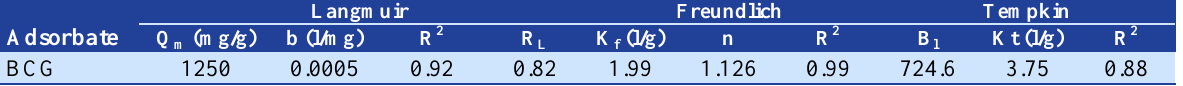
Table 2. Parameters of the Langmuir, Freundlich, and Tempkin isotherms Adsorbate